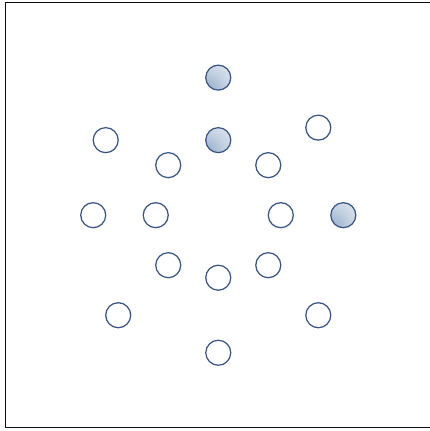
Figure3:Binarypatternofdifferentradius.Filledpatternrepresents 1 while the blank circle represents